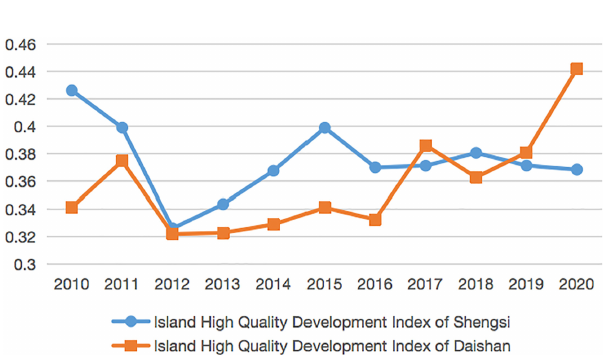
Table 1. Evaluation index system for the high- quality development of islands